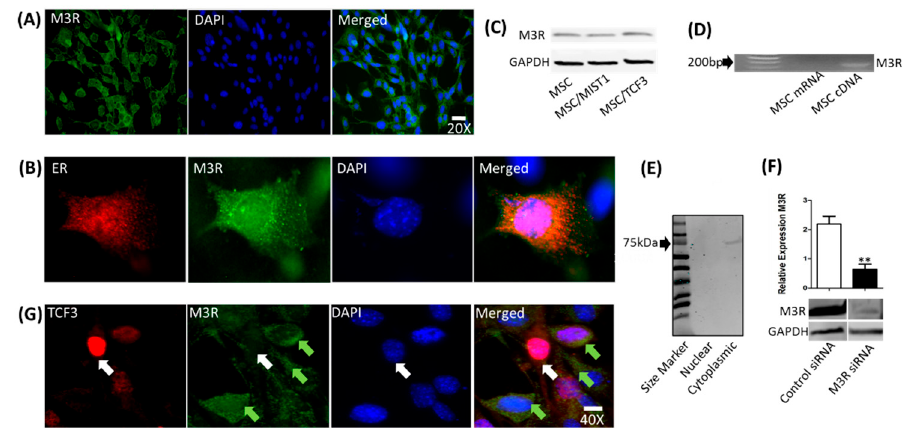
Figure 5. mMSCs express M3R in the cytoplasmic compartment co-localized to the endoplasmic reticulum (ER). ( A ) Generalized expression of M3R (green) localized to the cytoplasmic space of mMSCs, as shown in the top panel. Magnification of × 20; scale bar, 20 µ m. ( B ) To confirm M3R localization to the ER, cells were co-stained with antibodies specific to M3R (green) and ER (red). At the single cell level, the merged image confirms the localization of M3R in the ER by the observed orange color (scale bar, 2 µ m). DAPI was used for nuclear staining. ( C ) Furthermore, WB was performed to confirm M3R protein expression in transfected and untransfected MSCs. ( D ) RT-PCR was also performed to confirm M3R mRNA expression of MSCs. ( E ) Additionally, nuclear and cytoplasmic protein fractions from mMSCs analyzed by WB confirmed the confinement of M3R to the cytoplasmic compartment. ( F ) Knocking down M3R with a sequence-specific siRNA led to a significant reduction of the M3R level. ** p < 0.01 by Student’s t -test. ( G ) At 24-h post-transfection, TCF3 expressing mMSCs demonstrated reduced expression of M3R observed in the cytoplasm (white arrows). Cells that have low or no expression of TCF3 maintained M3R expression (green arrows). Magnification of × 40; scale bar, 5 µ